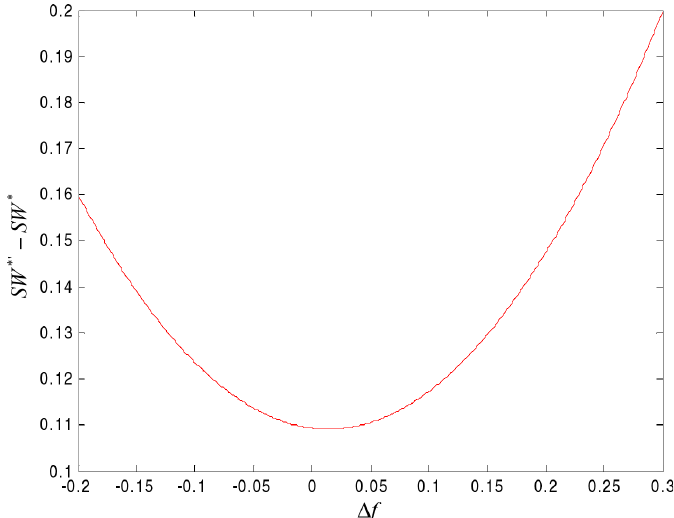
Figure 2. The value of SW * ' – SW * varies with Δ f (if v o = 1 , v c = 1.8 and v p = 2